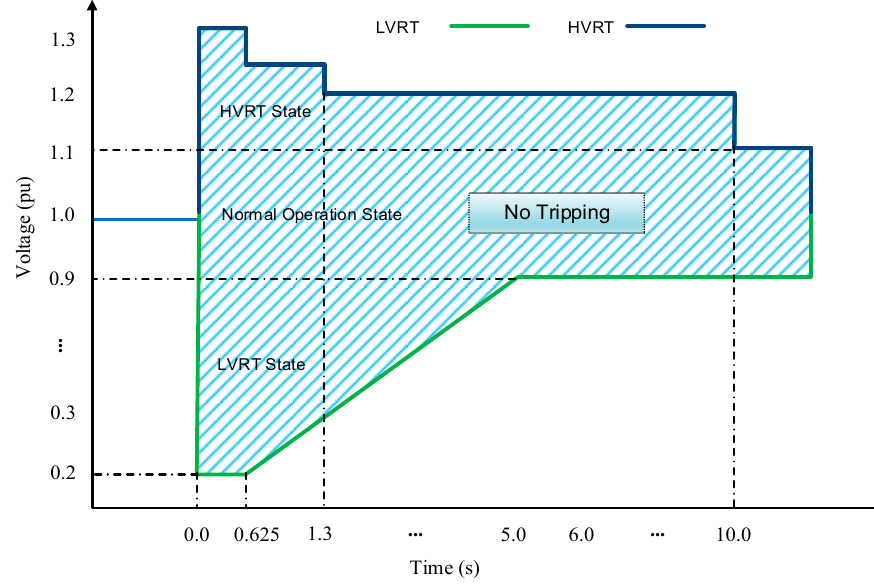
Figure 1. An example of fault ride-through (FRT) grid codes.